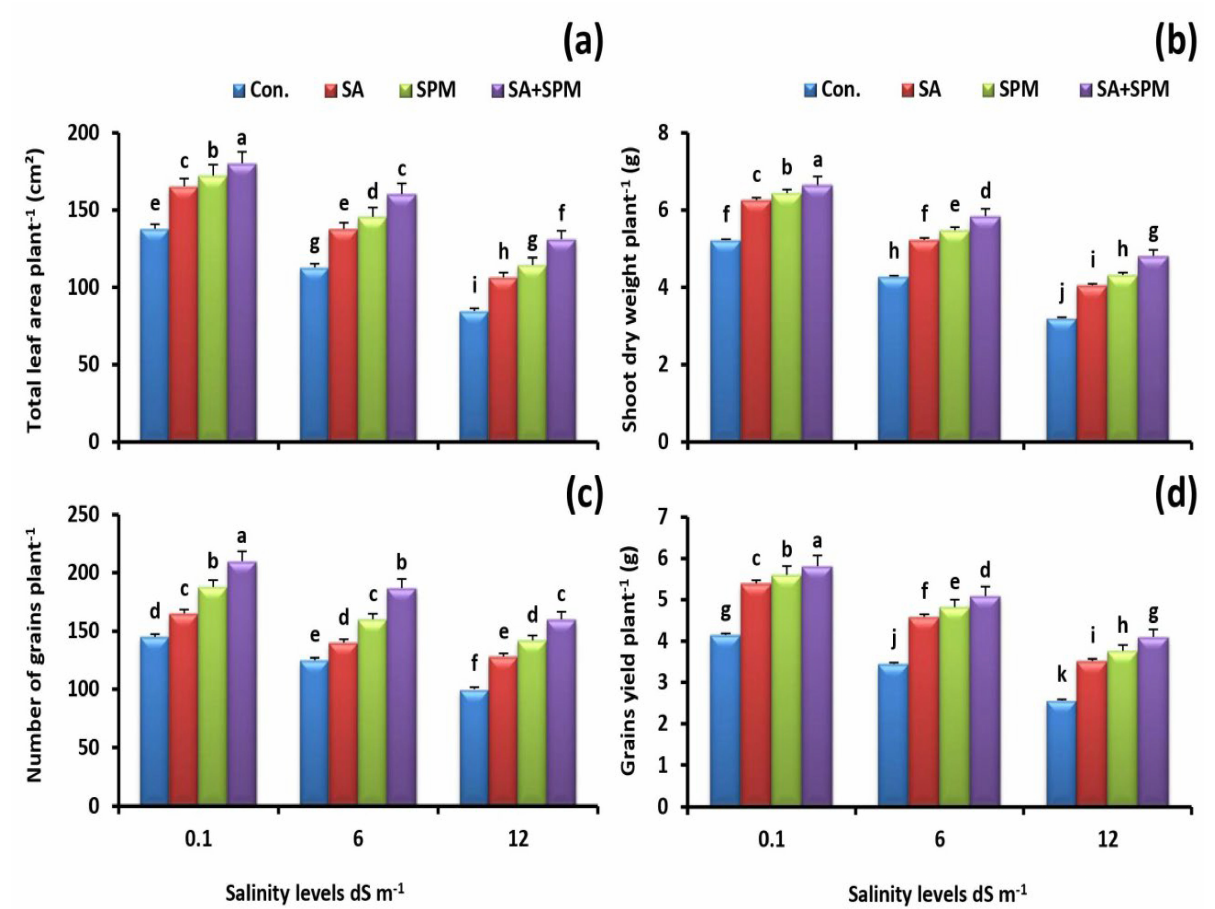
Figure 1. Effect of salicylic acid (SA) Spermine (SPM) foliage applications on growth and yield attributes ( a ) total leaf area plant-1, ( b ) shoot dry weight plant-1, and ( c ) number of grains plant-1 and ( d ) grains yield plant-1 of wheat plants exposed to non-saline and saline (6.0 and 12.0 dS m − 1 ) conditions. The results showed the mean ± SE of four replicates. Different letters indicate significant differences at ( p < 0.05) level according to Duncan’s